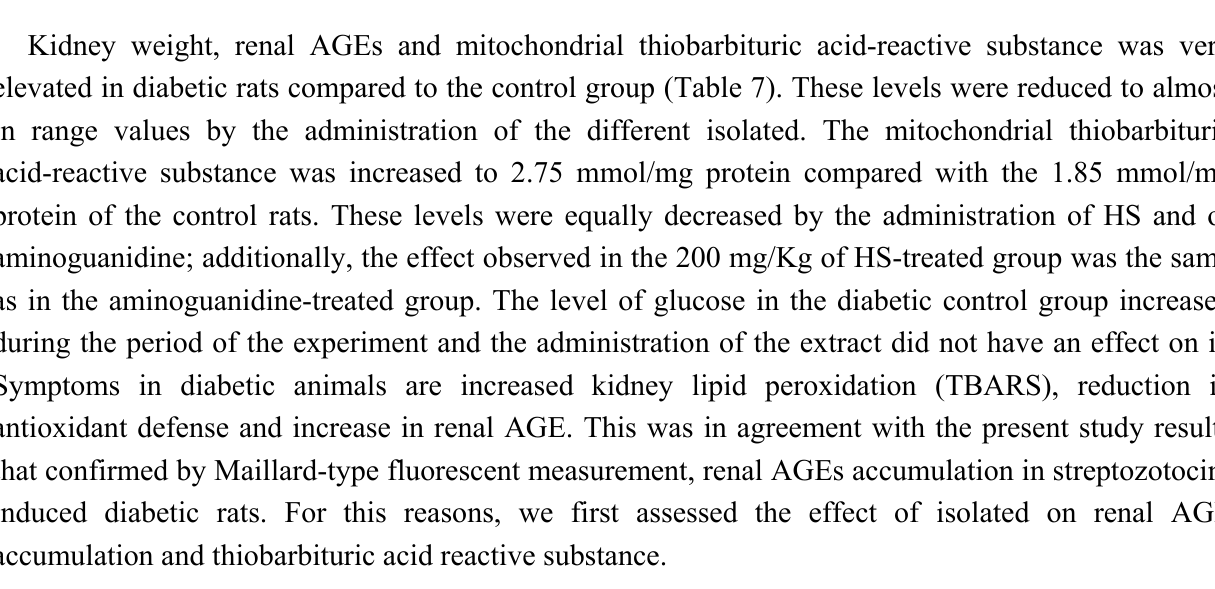
Table 7. Effect of HS on kidney contents of TBA-reactive substance, glucose, AGEs and renal weight.